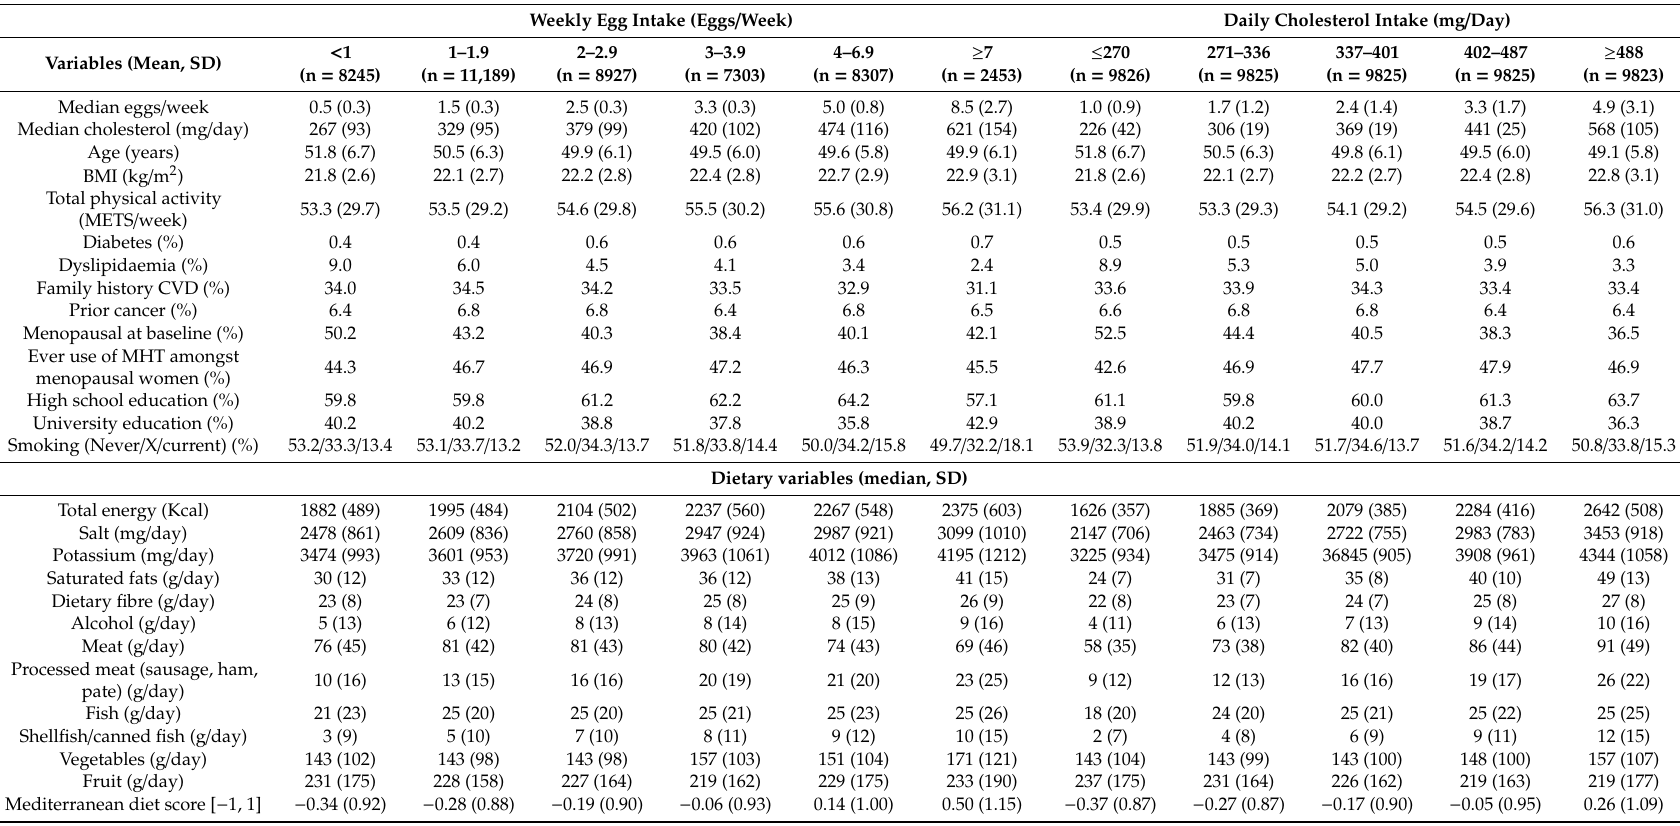
Table 1. Participant demographics and dietary data, depending on egg and cholesterol consumption at